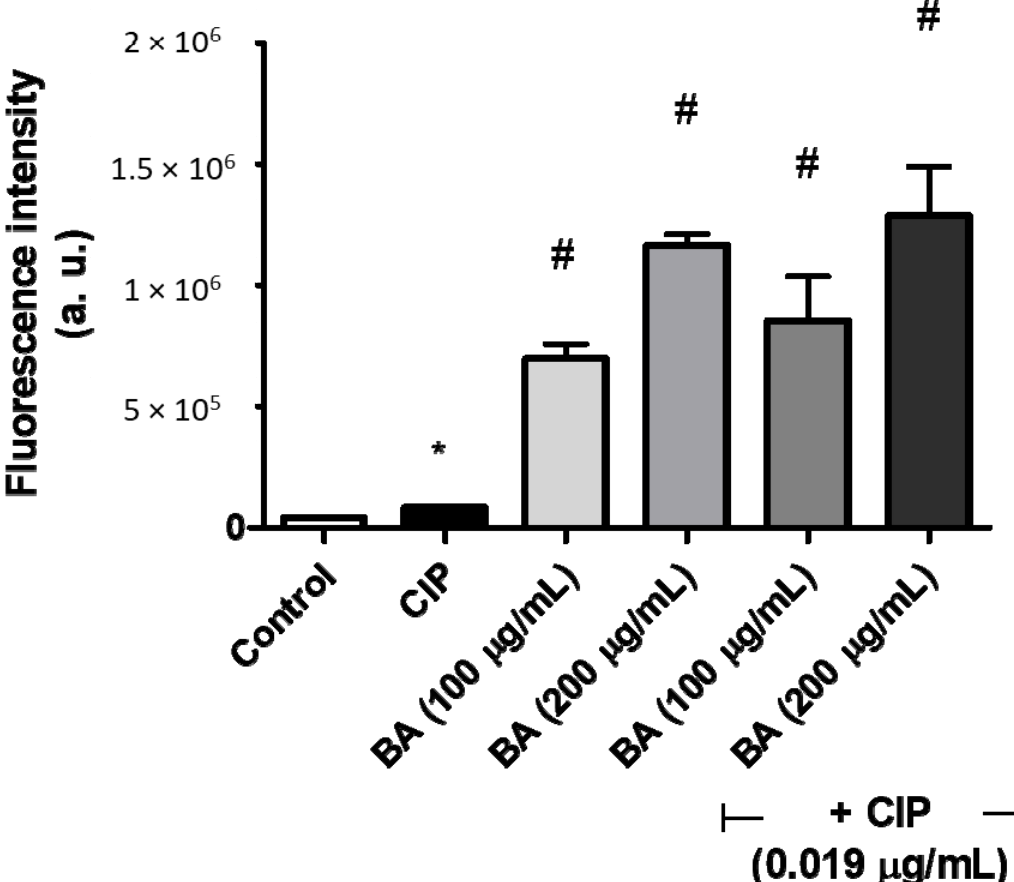
Figure 5. Effect of betulinic acid alone or in combination with ciprofloxacin on the bacterial membrane potential. S. aureus ATCC 6538 was incubated with ciprofloxacin (0.019 μ g/mL) alone or in combination with betulinic acid (100 or 200 μ g/mL). After 3 h, the cells were labeled with Rhodamine 123 and analyzed using fluorescence microscopy. CIP — ciprofloxacin; BA — betulinic acid. * indicates statistical differences related to the untreated cells ( p < 0.05). # indicates statistic differences related to the ciprofloxacin-treated cells ( p < 0.05).